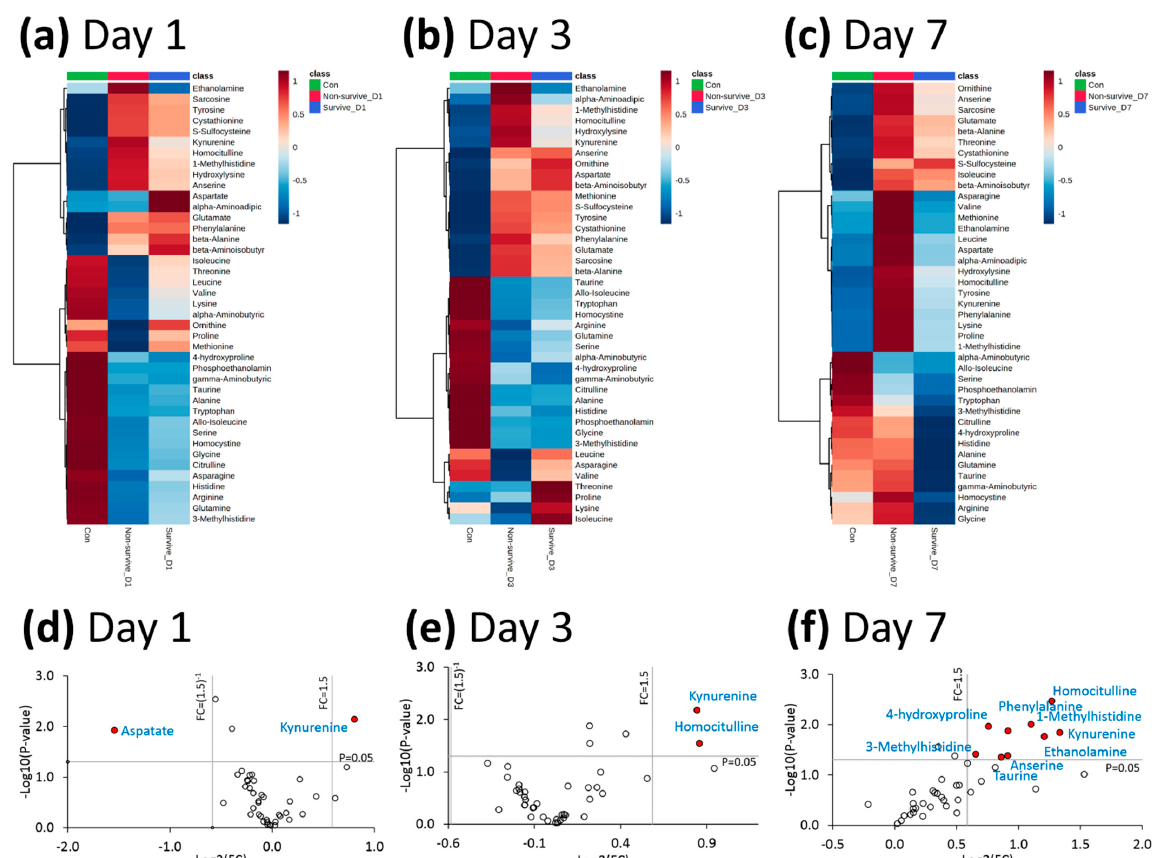
Figure 2. ( a – c ) Heat maps of amino acids and biogenic amines among the survivors and non ‐ survivors of ARDS at day 1, day 3, and day 7 after ARDS onset, as well as healthy control subjects. ( d – f ) Volcano plots of the amino acids and biogenic amines, comparing survivors and non ‐ survivors of ARDS at day 1, day 3, and day 7 after ARDS onset. Data were selected at the cutoff point for a p ‐ value < 0.05 and an FC < 0.66 or >1.5. ARDS: acute respiratory distress syndrome; FC: fold change.